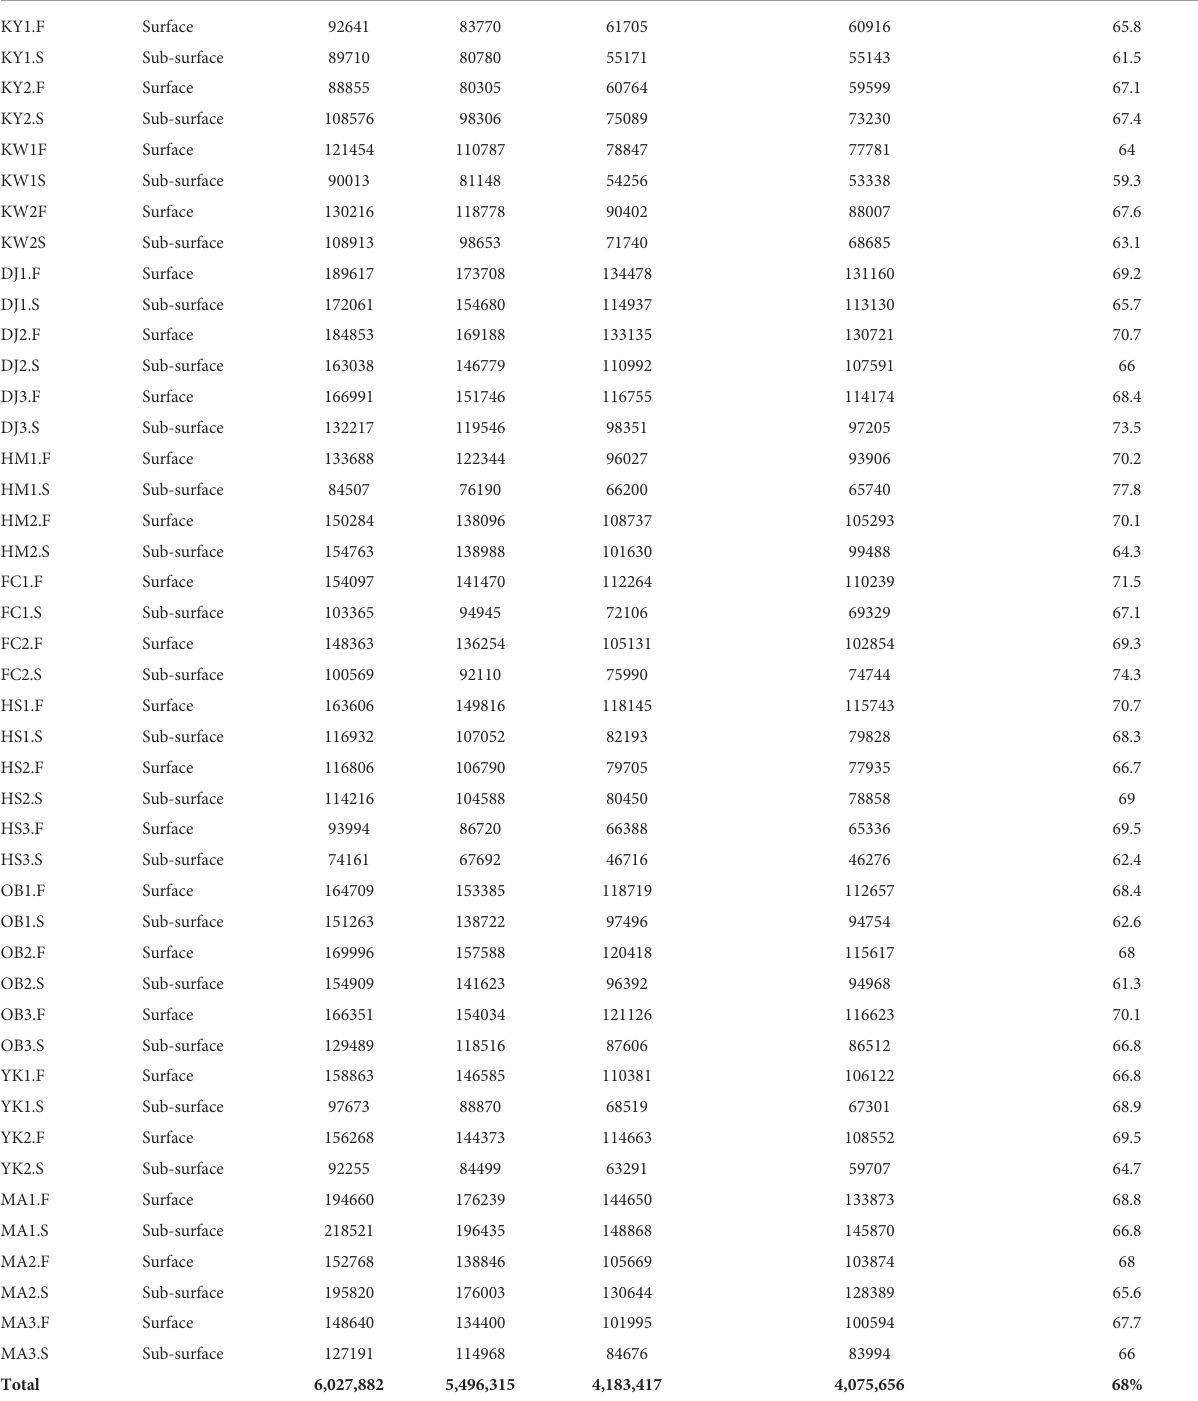
TABLE 3 Summary of bioinformatics analysis using DADA2 pipeline (raw reads count, fi ltered read count, merged, high-quality reads, and reads retained percent) at all studied sites. Sample & ID Sediment layer Raw reads Filtered reads Merged reads High-quality reads (Nonchimeric) reads retained %